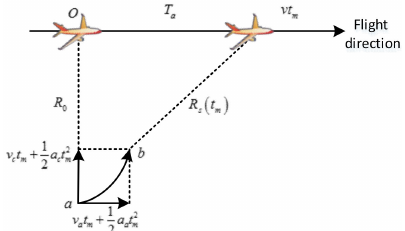
Figure 1. Motion geometry relationship between the synthetic aperture radar (SAR) platform and the ground moving